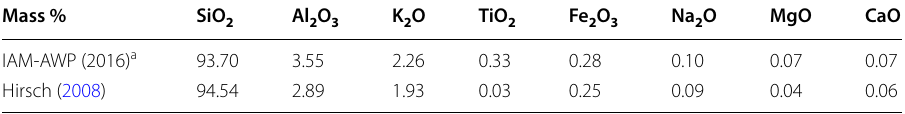
Table 2 Major element composition of the initial sandstone compared to the reference values of Hirsch (2008)